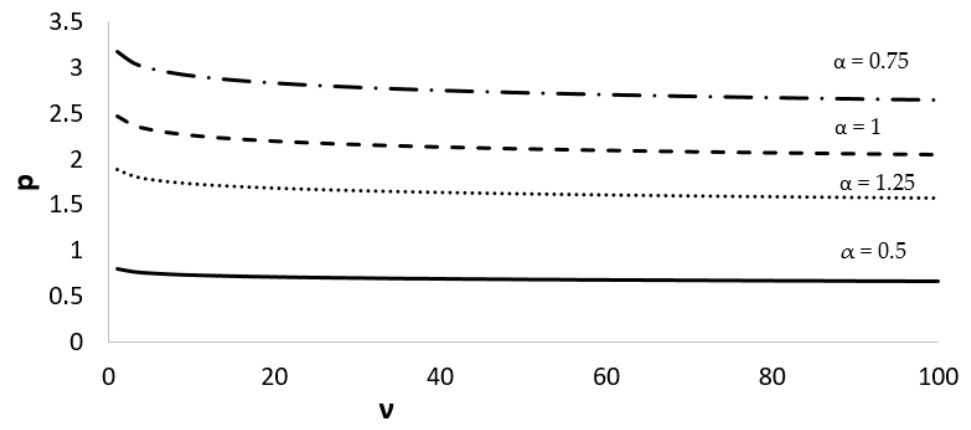
Figure 1. Variation in p with ν at several stages of the process.